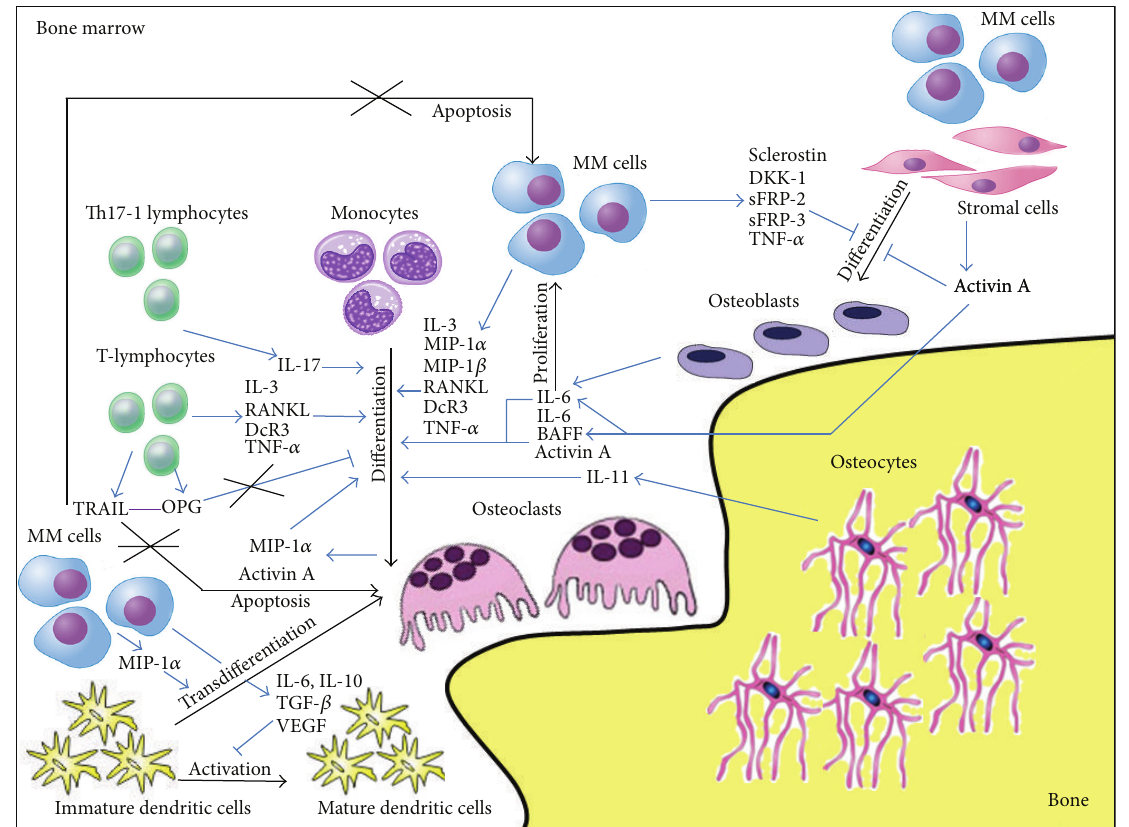
Figure 1: Interaction between bone cells and bone marrow microenvironment cells in promoting both malignant plasma cell survival and bone lesions in MM patients. Myeloma cells can directly support osteoclast formation and activity as well as inhibit osteoblast differentiation by releasing numerous cytokines. Moreover, other molecules can be secreted by bone cells and other cells interacting with each other in the bone microenvironment, thus supporting both the progression of MM tumor burden and the development of MM bone disease.